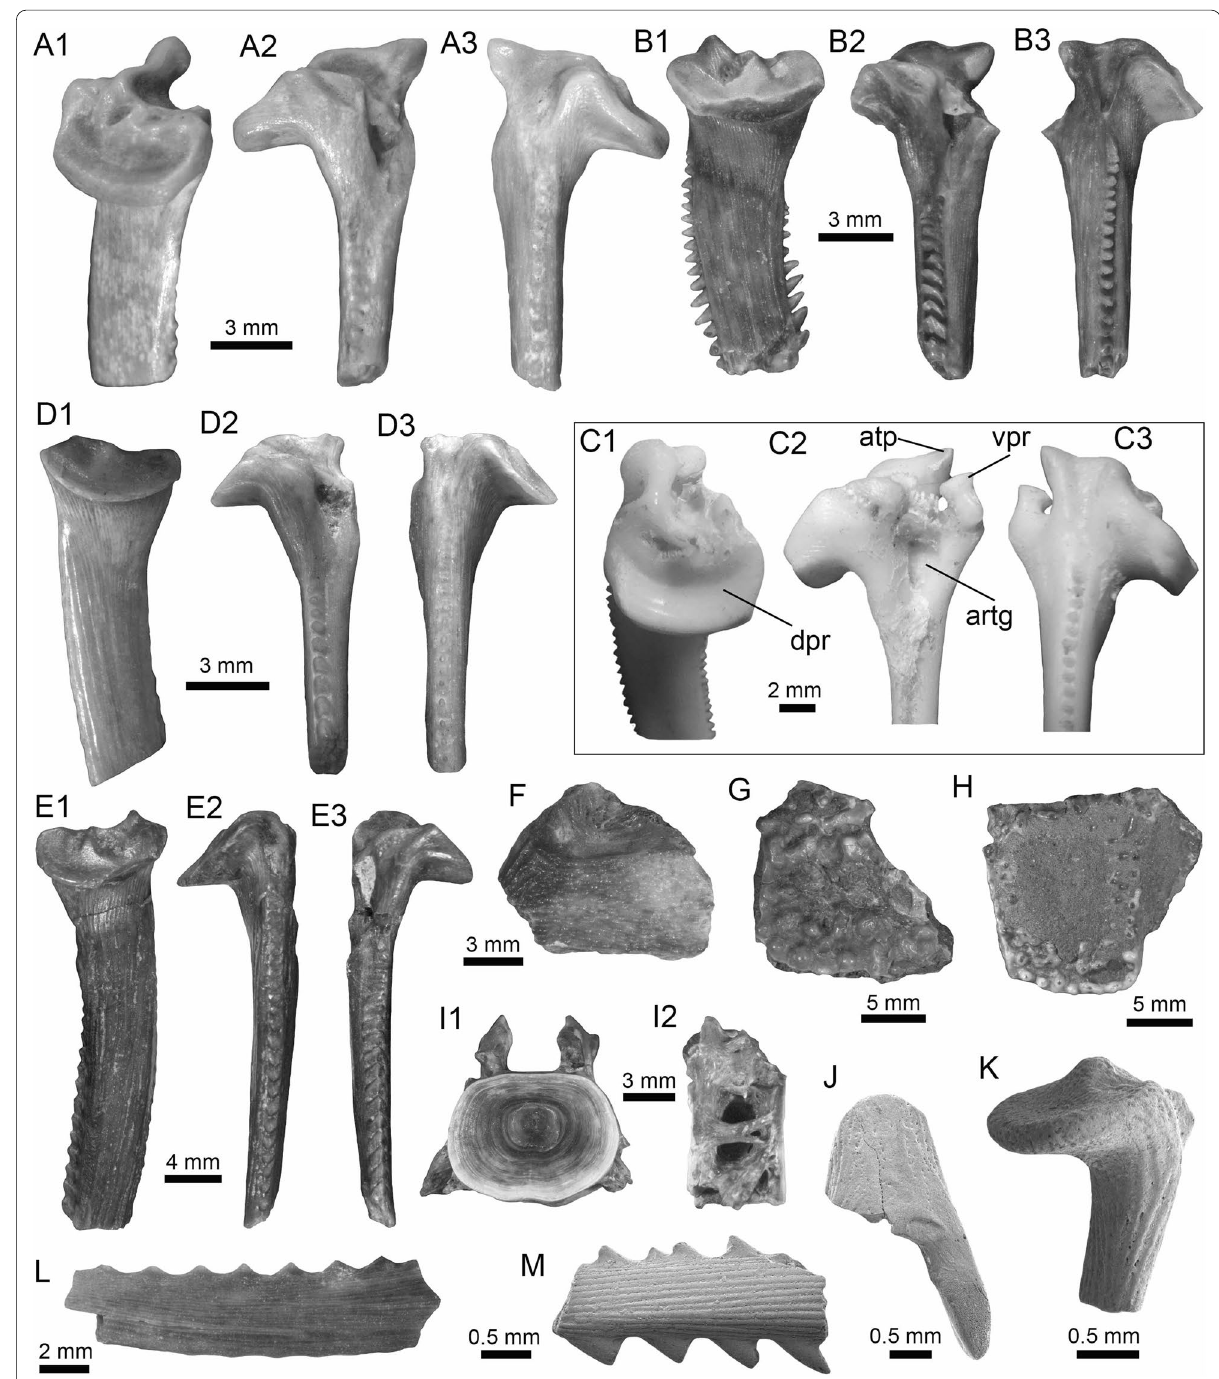
Fig. 11 Siluriformes (Pimelodidae and indet.) from the Vergel Member. A1 – B3 Left pectoral spines of cf. Platysilurus sp. (AMU‑CURS‑1172). C1 – C3 Left pectoral spine of extant Platysilurus malarmo (ANSP 187009). D1 – E3 Left ( D1 – D3 ) and right ( E1 – E3 ) pectoral spines of Pimelodidae indet. (AMU‑CURS‑1228). F – M Partial left cleithrum ( F AMU‑CURS‑1237), skull fragments ( G , H AMU‑CURS‑1175), precaudal vertebra ( I1 , I2 AMU‑CURS‑1174), first dorsal spine ( J AMU‑CURS‑1181), right pectoral spines ( K AMU‑CURS‑867), and pectoral spine fragments ( L AMU‑CURS‑867 and M AMU‑CURS‑1229) of Siluriformes indet. Views: anterior ( A3 , B3 , C3 , D3 , E2 , I1 , J ), lateral ( I2 ), posterior ( A2, B2 , C2 , D2 , E3 ), dorsal ( A1 , B1 , C1 , D1 , E1 , F ), anterodorsal ( K ), and indet. ( G , H , L , M ). atp anterior process, artg articular grove, dpr dorsal process, vpr ventral